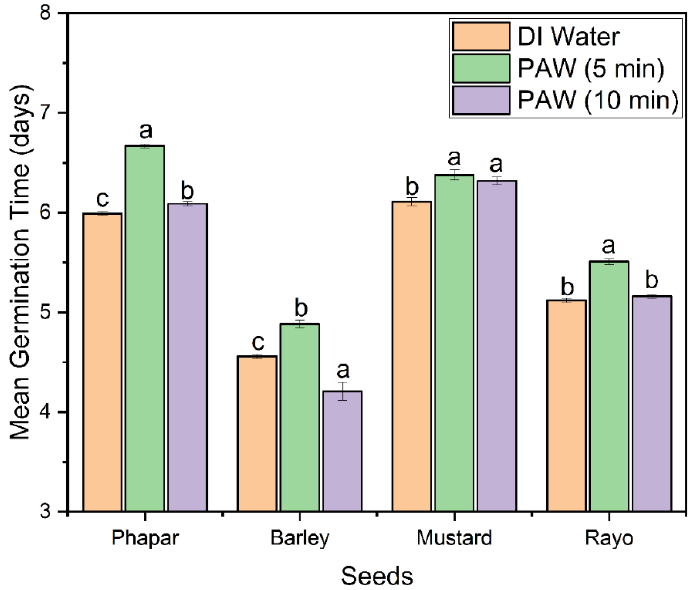
Figure 6. Influence of PAW on the mean germination time (MGT) of seeds. Different letters (a – c) indicate significant differences at p < 0.05 level among all treatments as determined by Tukey's multiple comparison test.